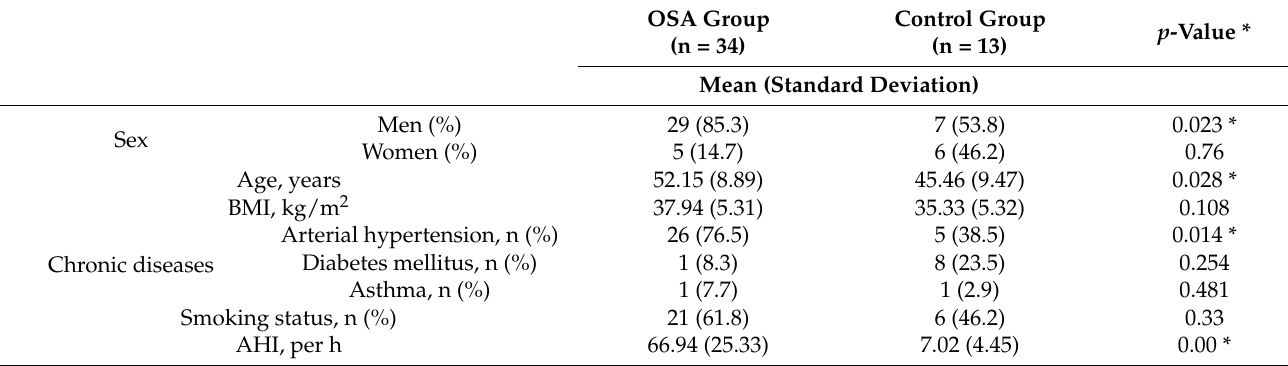
Table 1. Characteristics of OSA and control group subjects.